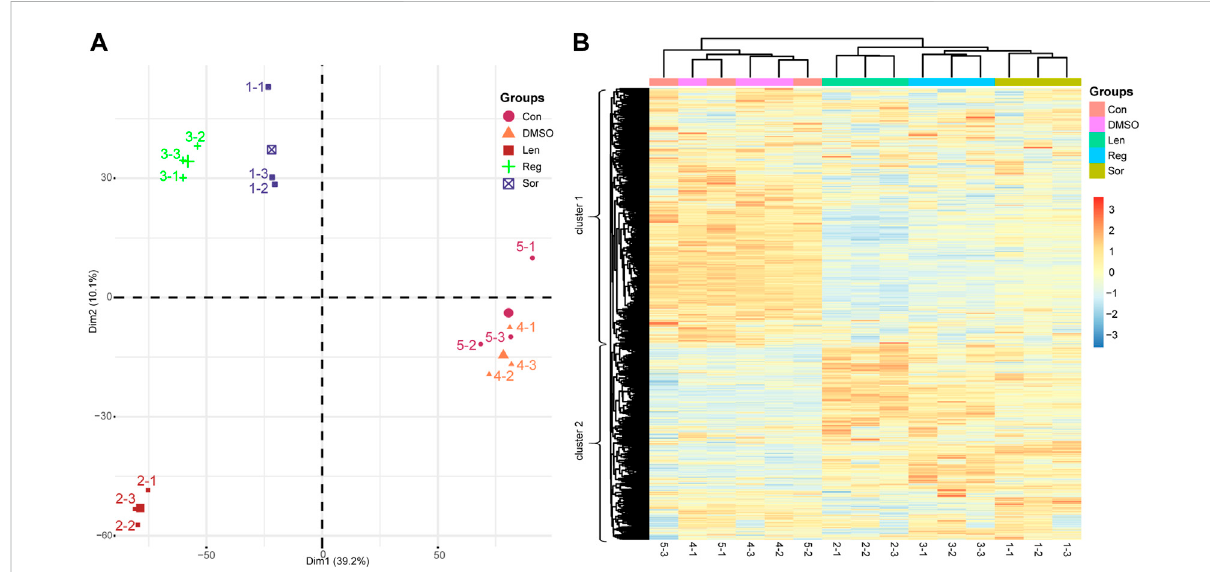
FIGURE 4 Principal component analysis (A) and hierarchical clustering analysis (B) based on the proteomic data obtained from the Huh-7 cells treated by 72 hincubationwithrespectivesorafenib(Sor),lenvatinib(Len)andregorafenib(Reg)attheirIC 50 aswellasnormalsaline(Con)and0.1 ‰ DMSO.The fi ve experimental groups are indicated by different colors and numbers (1 – 5). For heatmap, samples are shown as columns; and proteins arrayed in rows; branch length indicates the degree of variance; and color in row presents the normalized regulated level of the proteins. Each group contains three samples ( n =